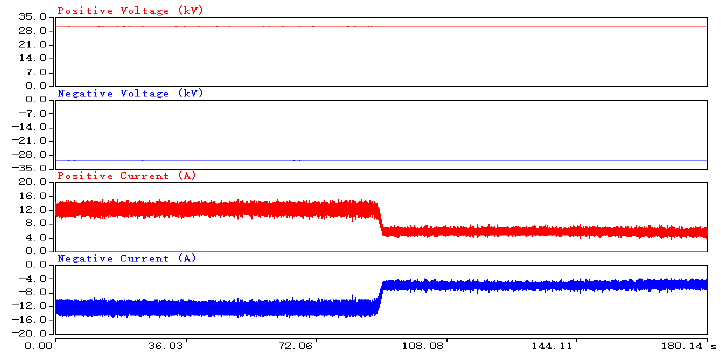
Figure 31. MPPT mode to Power limiting operation mode.